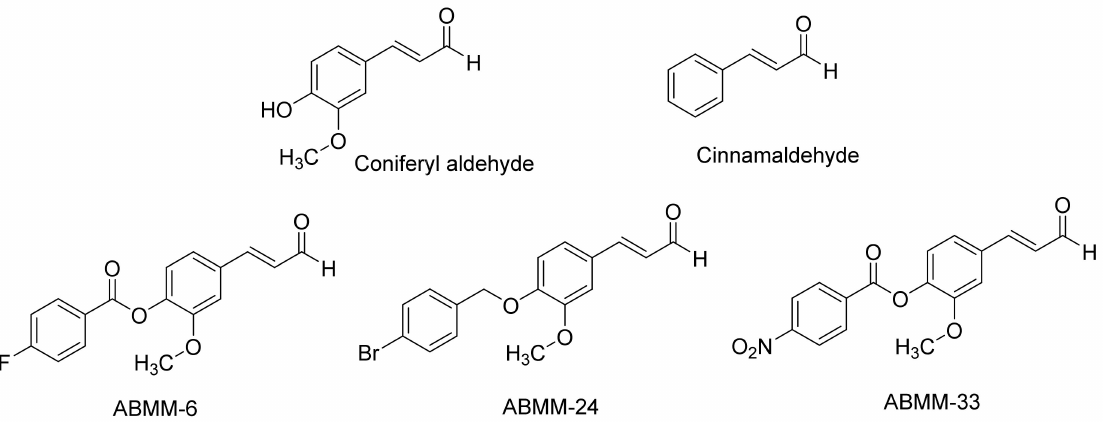
Figure 3. Chemical structures of selected